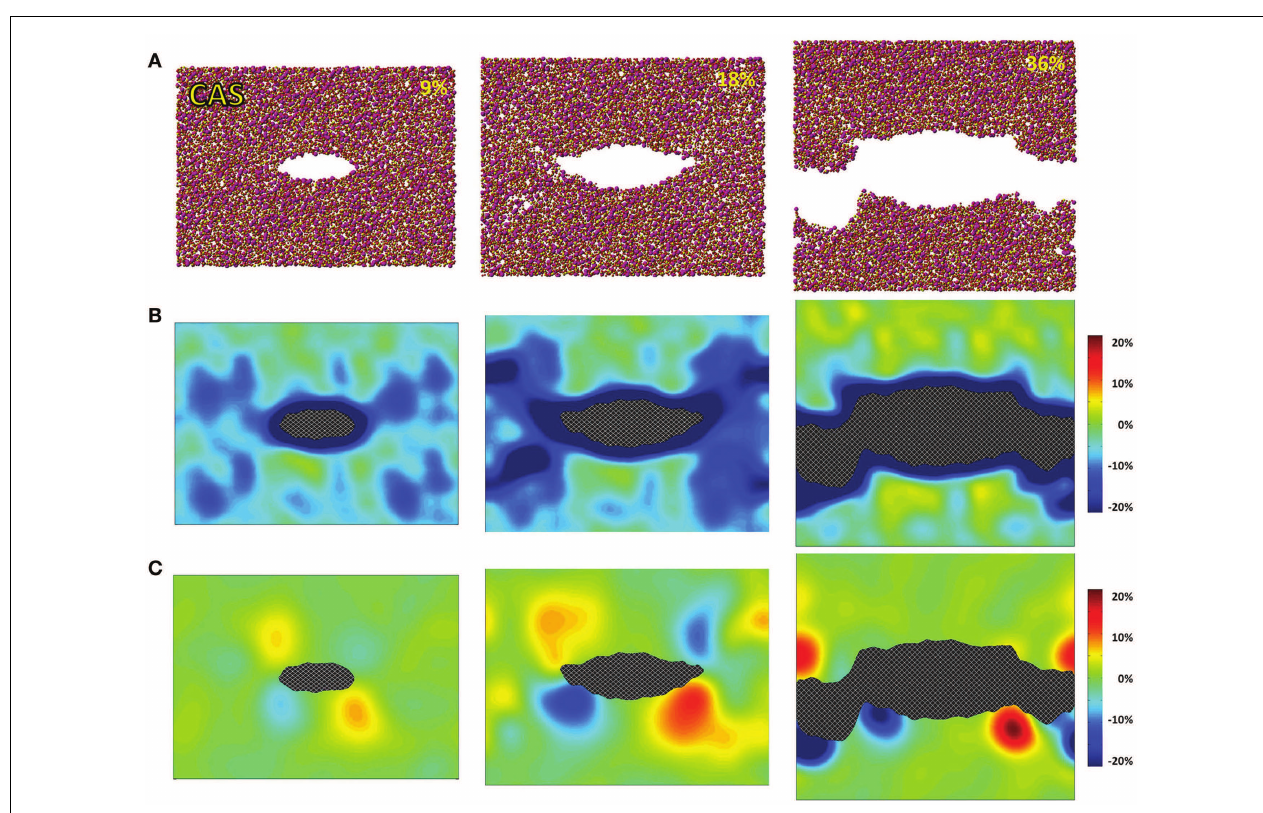
FIGURE 3 | Simulated calcium aluminosilicate (CAS) under 9, 18, and 36% strains . (A) Snapshots of the atomic configurations. Silicon, alumina, calcium, and oxygen atoms are in gold, yellow, magenta, and red, respectively; (B) local density change in percentage compared with the bulk density; (C) local shear strain.